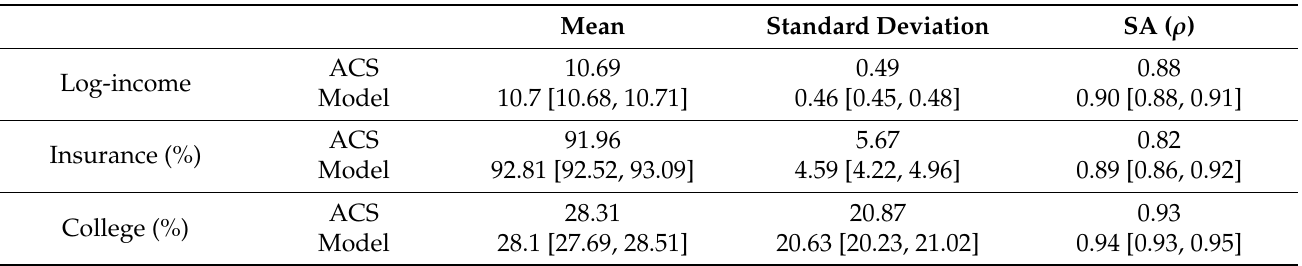
Table 3. Summary statistics for select ACS variables, Milwaukee County census tracts, comparing raw ACS data to the posterior distribution of the CAR data model for the same variables.